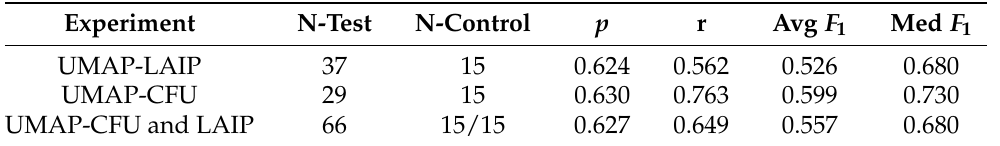
Figure 5. UMAP embedding of a MRD positive FCM sample using ( A ) 5-color backbone panel, ( B ) the 8-color LAIP panel, and ( C ) the full panel (LAIP plus drop-in markers). UMAP can only properly separate blasts in the embedding space given the drop-in markers. We cross-checked several UMAP embeddings with medical experts in cases where UMAP has a very clear separation of blast clusters but some remaining blasts mixed together with healthy cells. The blast gates of manual gating often were drawn through very dense areas, where slight shifts can have a big effect in terms of absolute numbers of blasts. In most cases (such as in ( C )), subsequently correcting the gates also resulted in more coherent clusters consistent with UMAP. Table 3. Results of the proposed classification pipeline with pre-filtered events for CFU and LAIP tubes separately as well as combined.